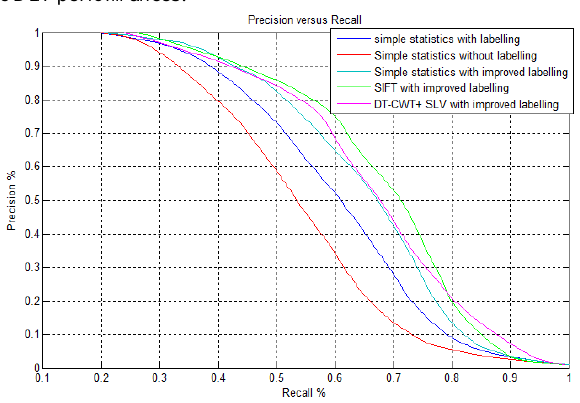
Figure 19. Precision-Recall curves obtained using the 800 samples.